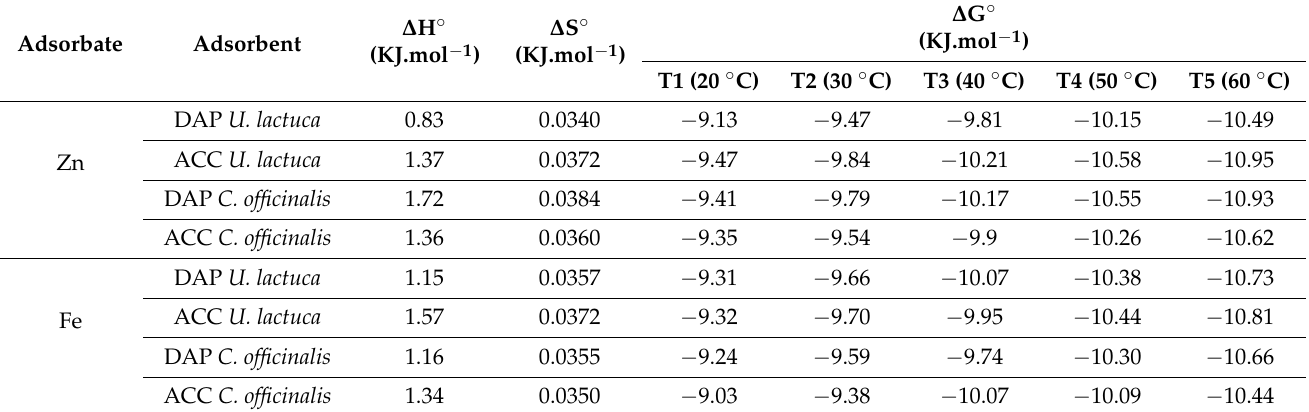
Table 1. Thermodynamic parameters for adsorption of Zn +2 , Fe +3 onto DAP and AAC of both Ulva lactuca and Corallina officinalis